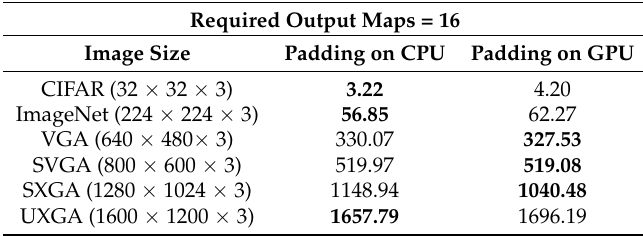
Table 4. Comparison of ConvMM execution time as a function of padding (ms), best results are written in bold.